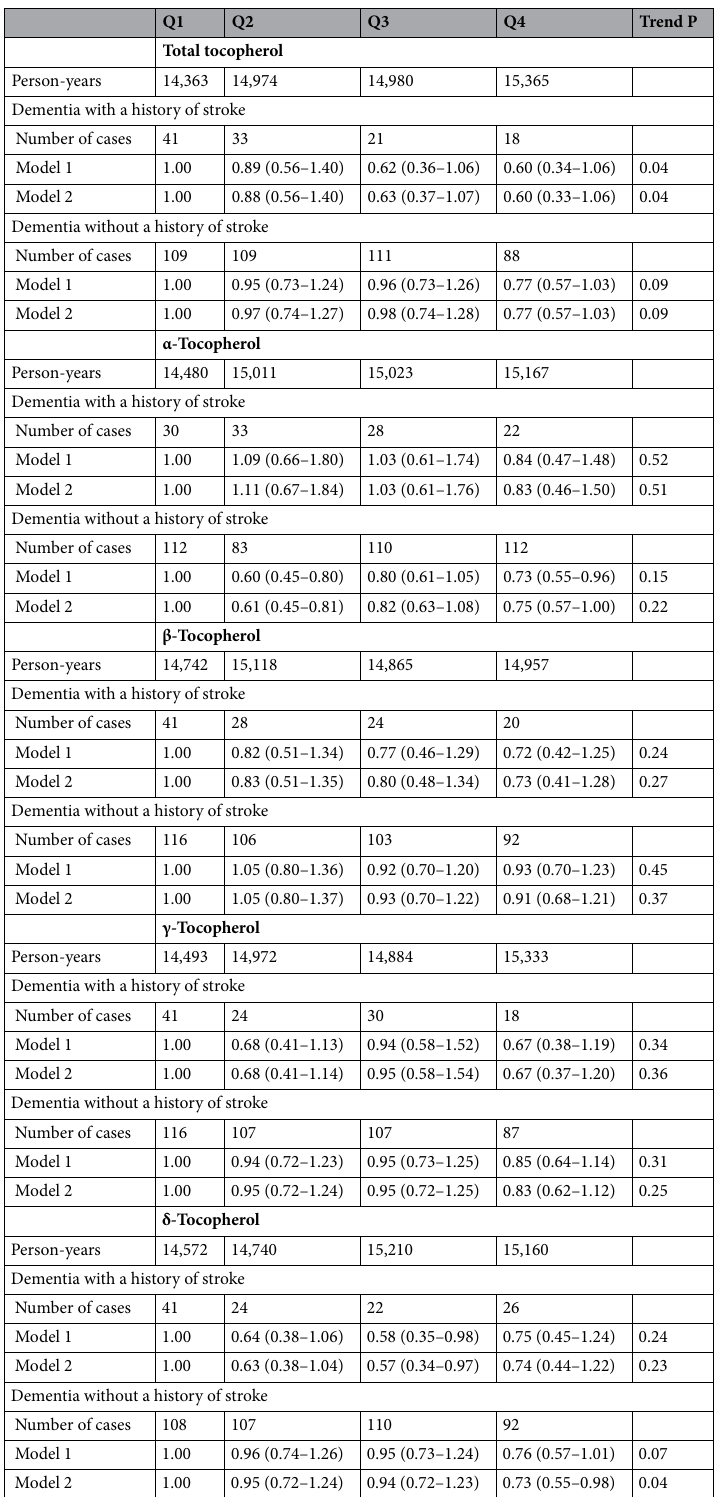
Table 3. Multivariable hazard ratios and 95% confidence intervals of disability dementia according to quartiles of total tocopherol, α-, β-, γ- and δ-tocopherol intakes. Model 1: Adjusted for age and sex, and stratified by area. Model 2: Multivariable model adjusted further for energy, smoking status, and DHA +